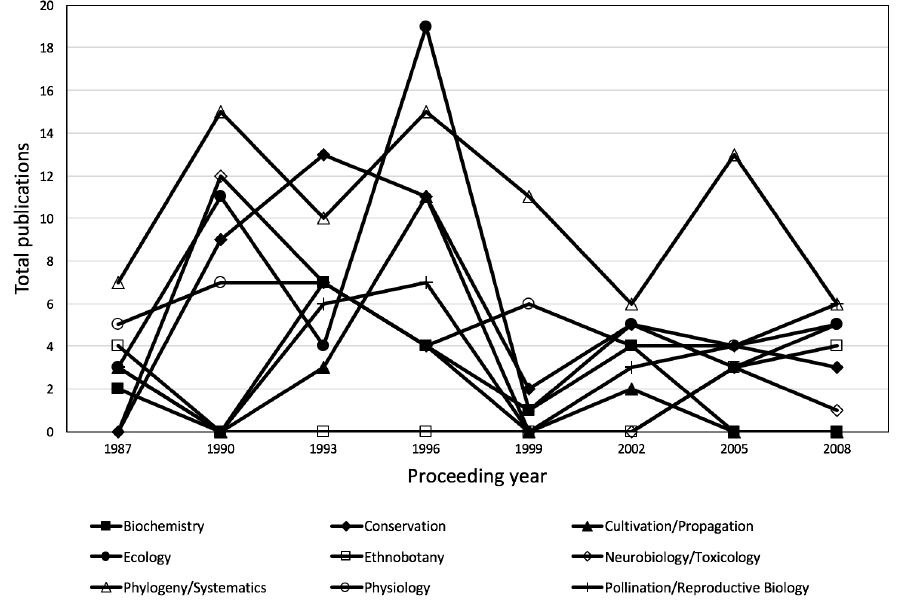
Figure 2. Total number of publications within